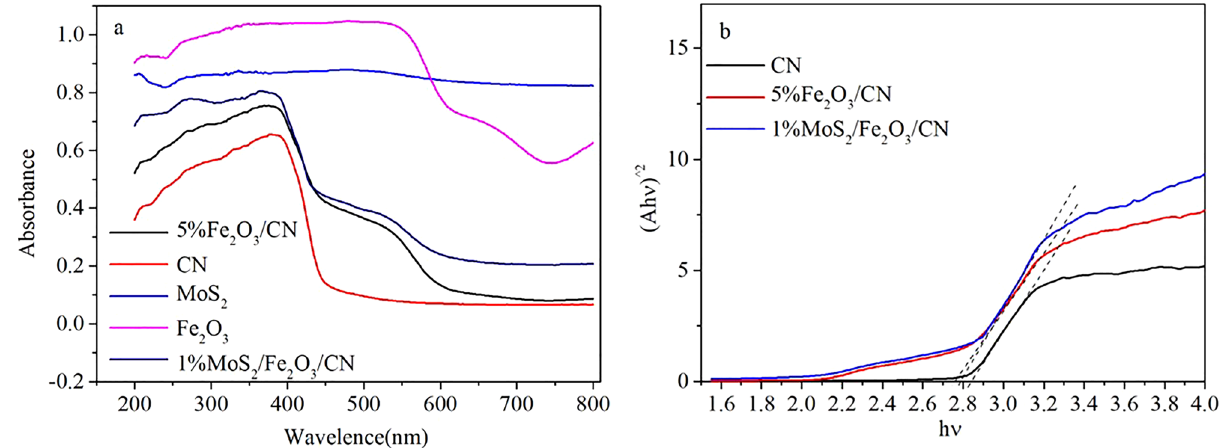
Figure 6. ( a ) UV–Vis absorption spectrum of photocatalysts ( b ) band gap diagram of photocatalysts.